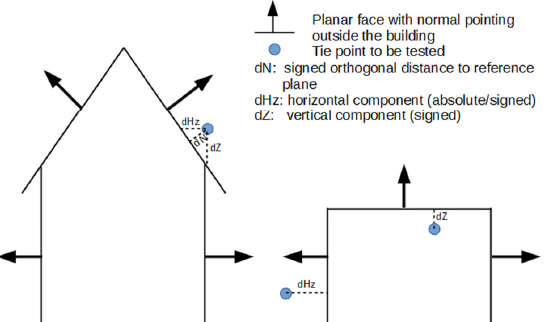
Figure 10. some measures derived from the tie point-to-reference plane